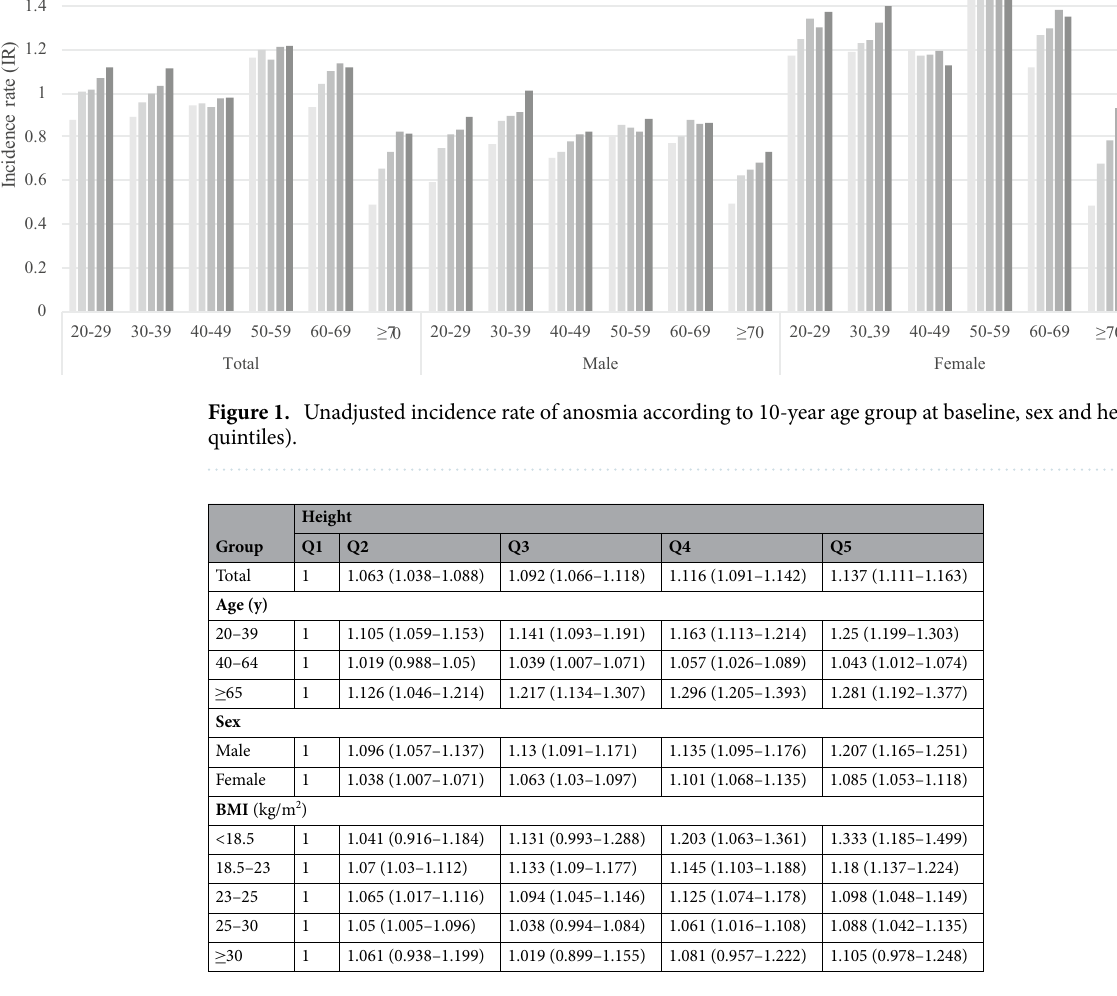
Table 2. Multivariate Cox’s proportional hazard regression model of the relationship between height and risk of anosmia. Model: adjusted for age, sex, BMI, income, smoking status, alcohol consumption, regular physical activity, hypertension, diabetes mellitus, dyslipidemia. BMI body mass index, HR hazard ratio, 95% CI 95% confidential interval of hazard ratio. Data are expressed as HR (95%